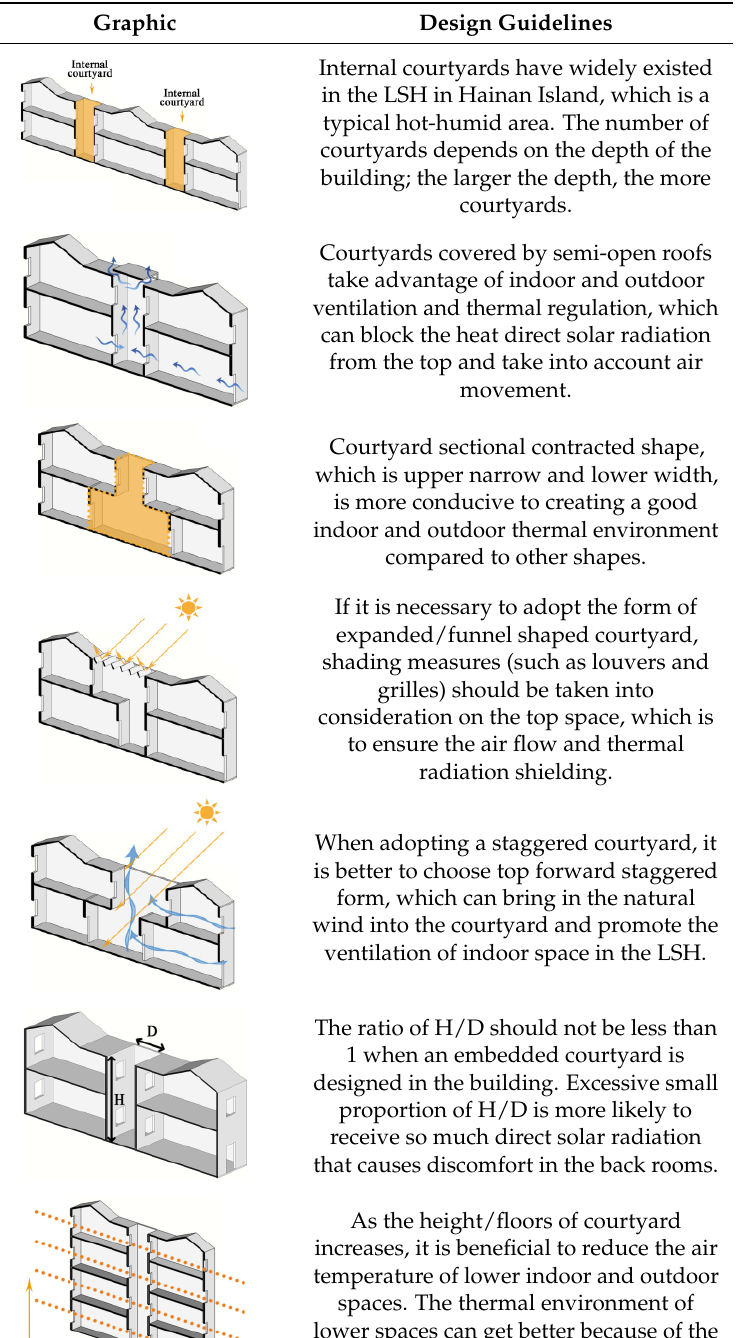
Table 7. Internal courtyard configuration design guidelines of LSH.